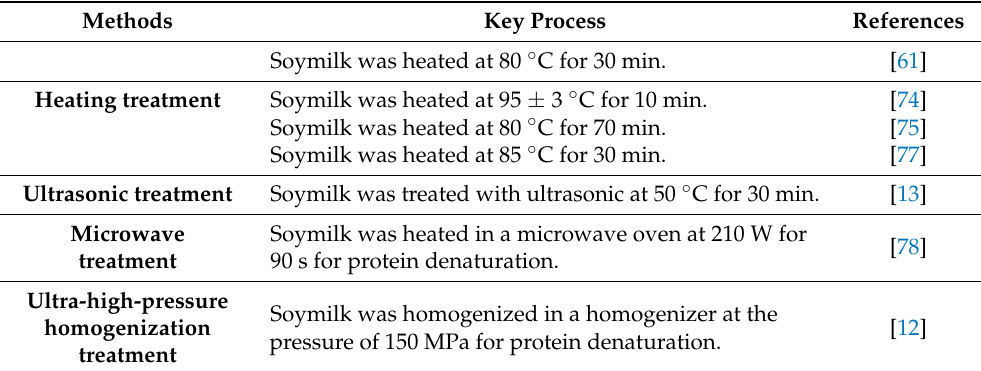
Table 2. Processes of denaturing soybean proteins in raw